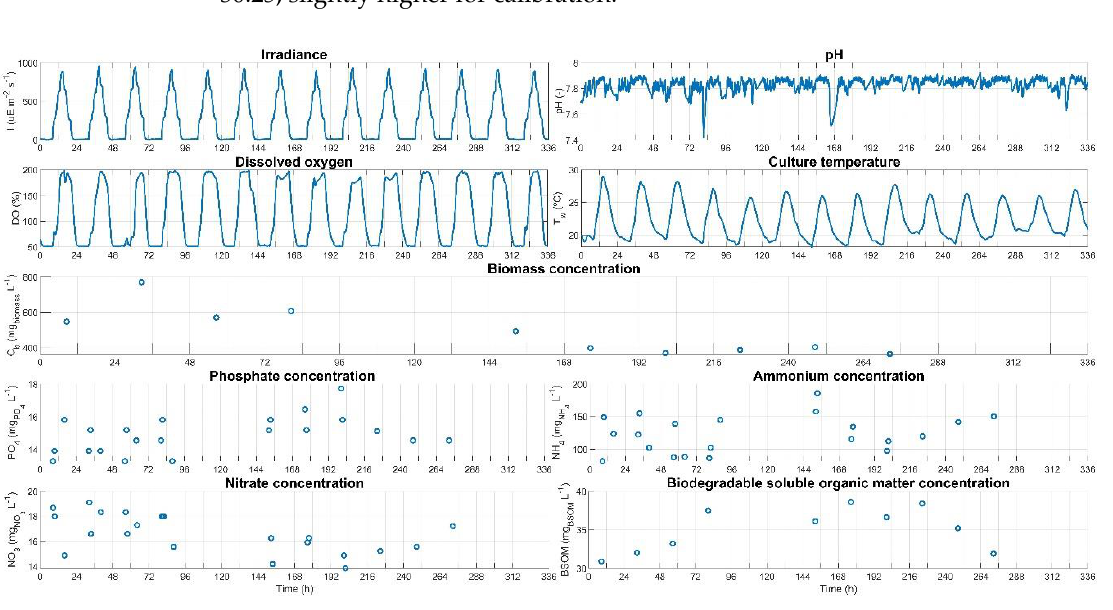
Figure 6. Input variables for validation.